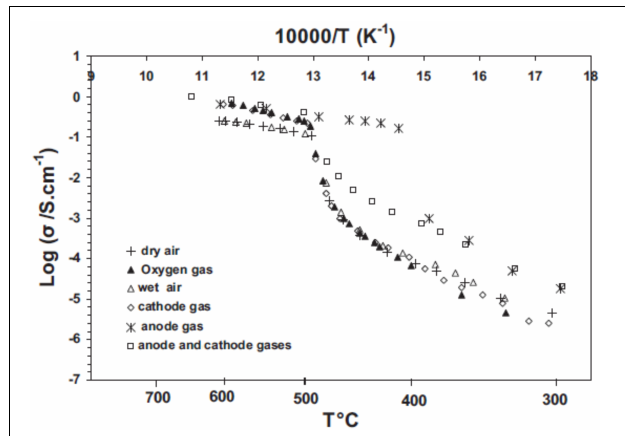
FIGURE 3 | Arrhenius plots of the conductivity of a GDC/ 30% Li-K sample under different atmospheres (Benamira et al.,